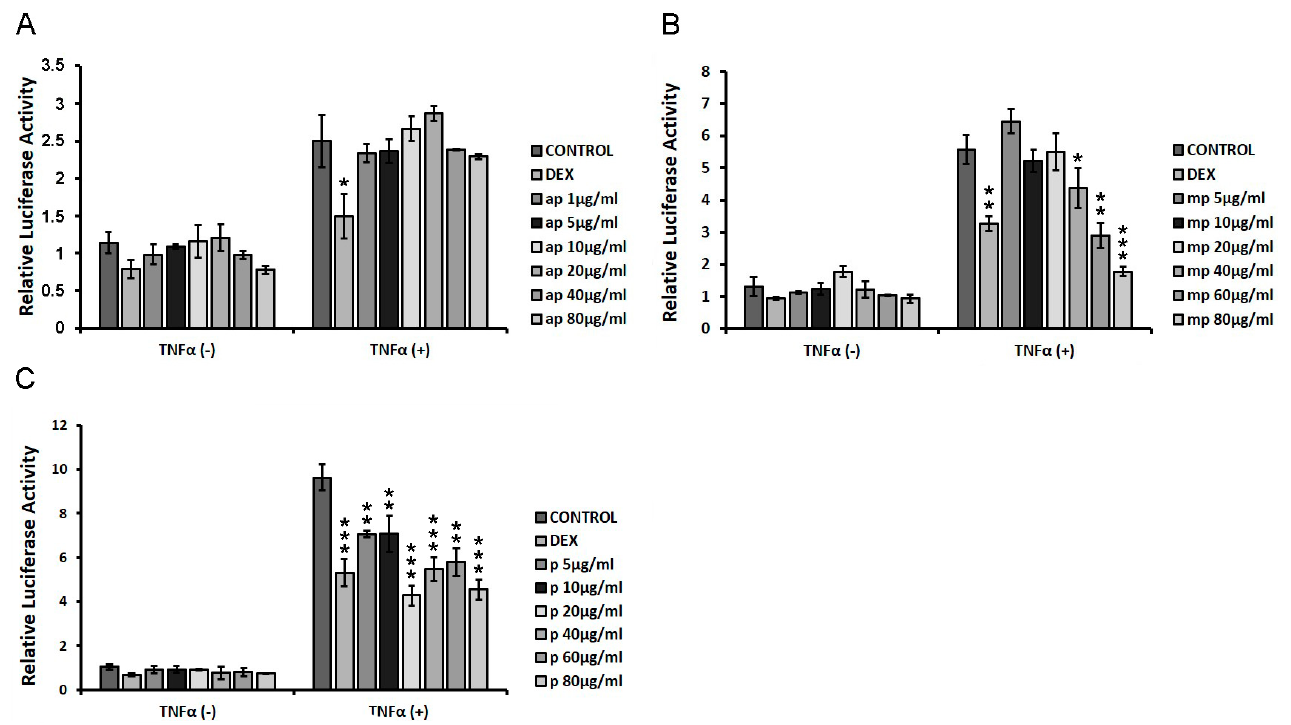
Figure 6. Chios Mastiha different polarity fractions suppressed the TNF α -induced NF- κ B transcriptional activation. NF- κ B-Luciferase reporter gene assay was applied in HEK293 cells treated with 1 µ M DEX or 1–80 µ g/mL of ( A ) apolar (ap), ( B ) medium-polar (mp), and ( C ) polar (p) Mastiha fractions and/or 20 ng/mL TNF α for 6 h. DMSO (1:1000) and EtOH (1:1000) were added in control condition. Relative luciferase activity results from normalization of luciferase activity to β -galactosidase activity. Relative luciferase activity of control cells was set as 1. Data are expressed as the mean ± SD, (n = 2–6), * p < 0.05; ** p < 0.01; *** p < 0.001.